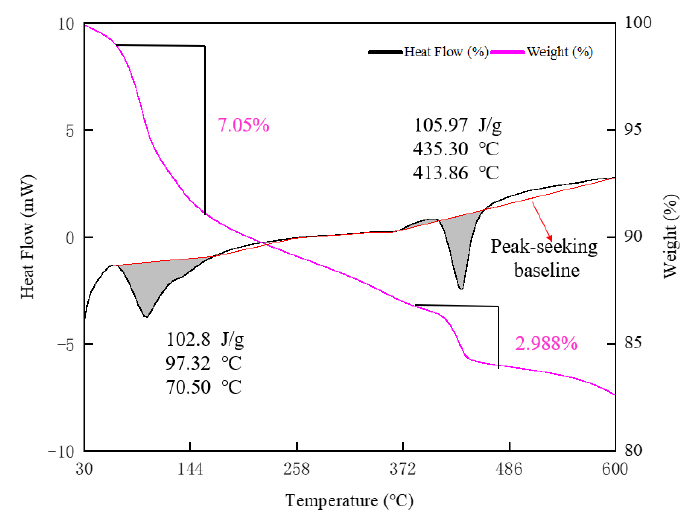
Figure 7. Typical DSC curve.